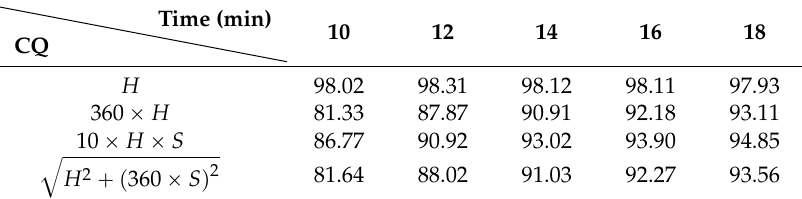
Table 4. Linear coefficient between characteristic quantities and OD value (%).